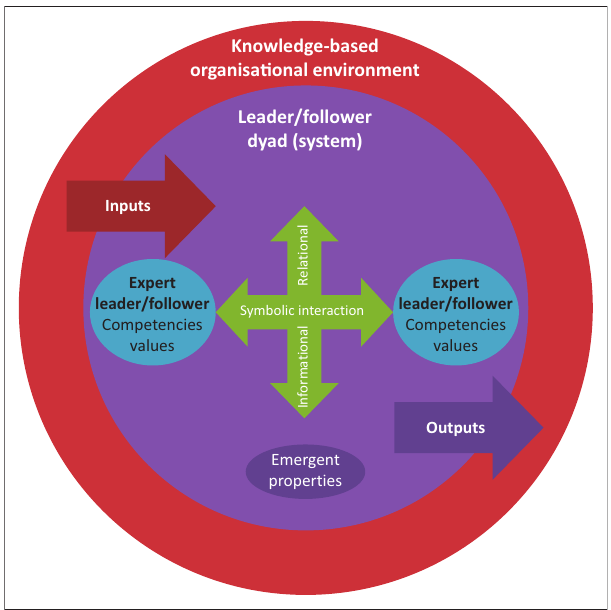
FIGURE 1: General model of interpersonal leadership relations.